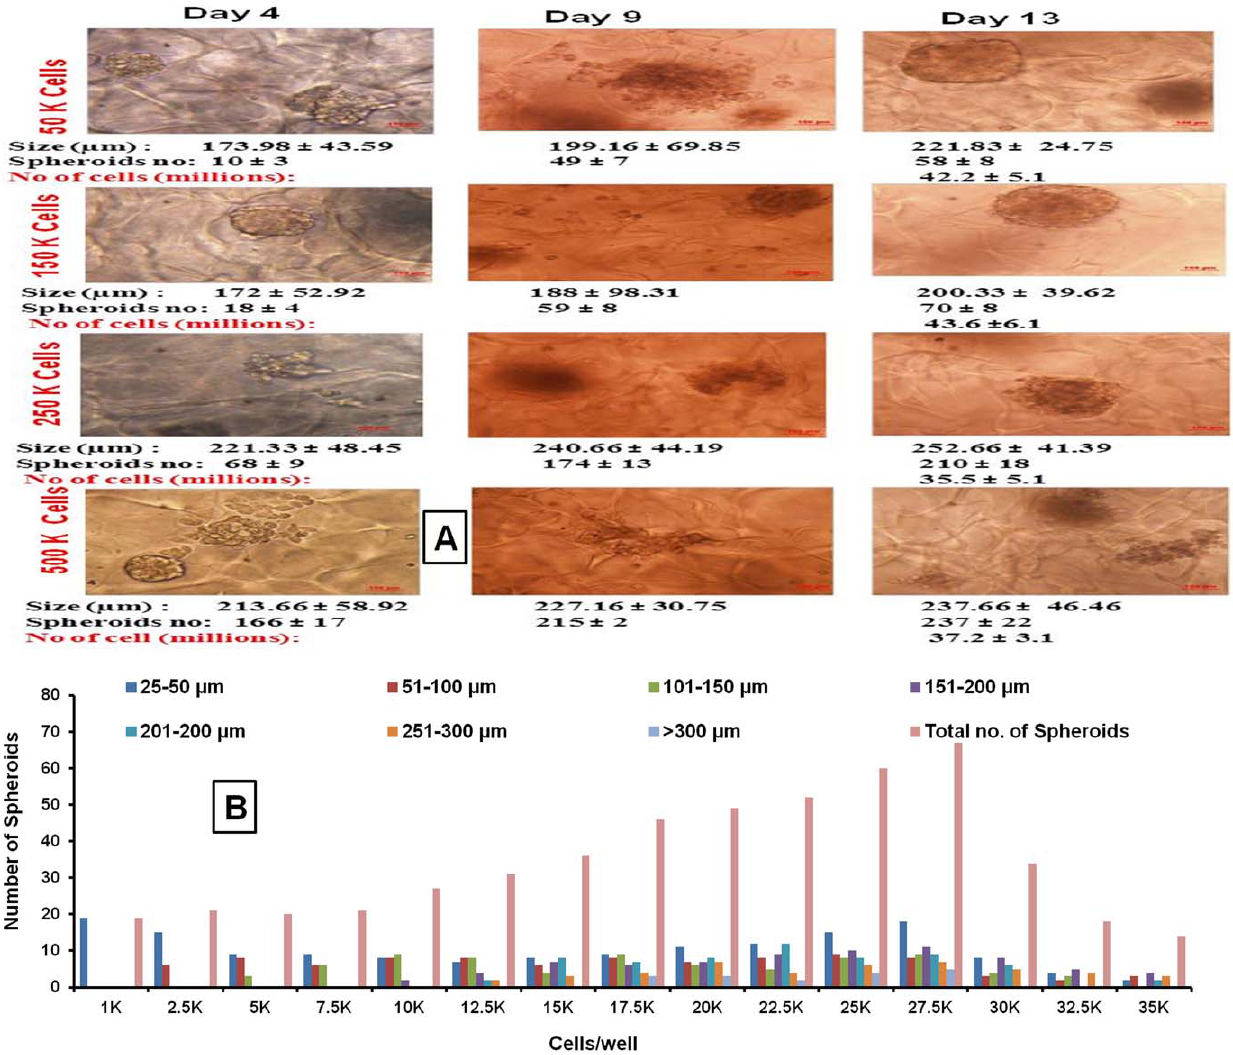
Figure 2. Development and optimization of an in-vitro 3D alginate scaffold system. A) H460 lung tumor model with different cell number over 13 d culture period in a 6 well plate. Figure 2A shows spheroids at 4 d and 13 d days post seeding with different seeding densities (0.05, 0.15, 0.25 and 0.5 million cells/well). Average spheroid size and number were noted at 4 d and 13 d post cell seeding into 3D alginate scaffold. At the end (13 d in culture) total number of cells per well were measured by alamarBlue H assay, B) Graphical and tabular representation of distribution of spheroids by size and seeding density in 96 well plate formats of 3D alginate scaffolds. H460 cells at varying cell density (1–35 6 10 3 ) were introduced into the each 96 plate wells and at the 13 th day in vitro tumors in spheroid forms were counted under inverted